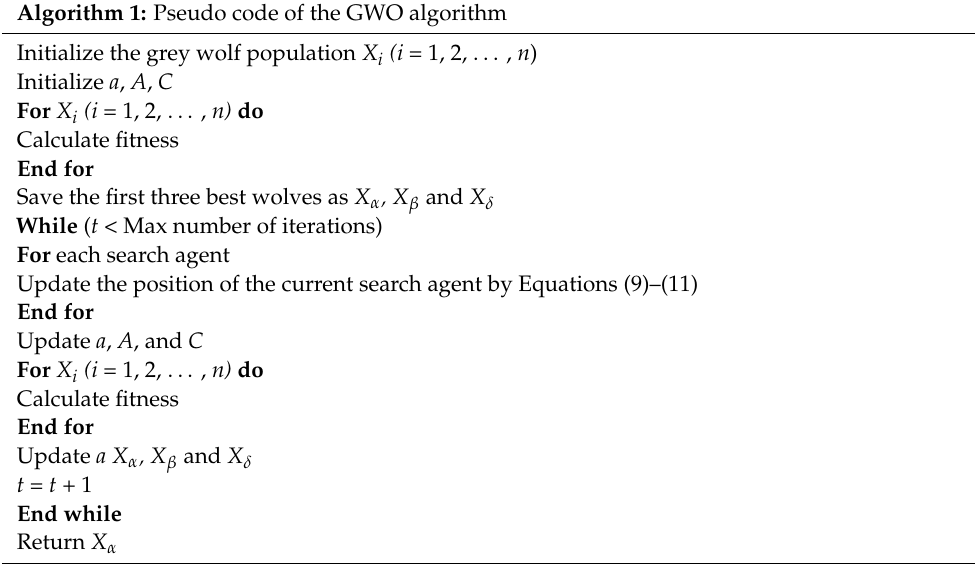
Algorithm 1: Pseudo code of the GWO